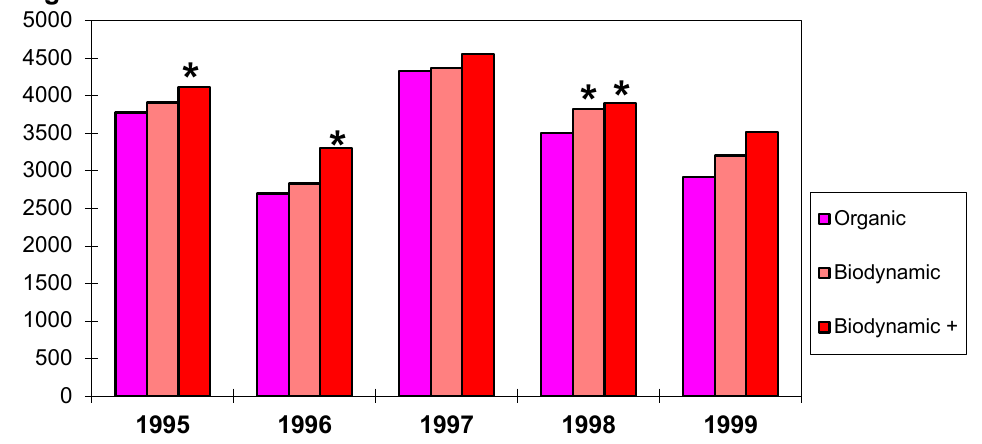
Figure 1: Grain yields of winter wheat as affected by different farming systems (Elkhorn, 1995-1999)